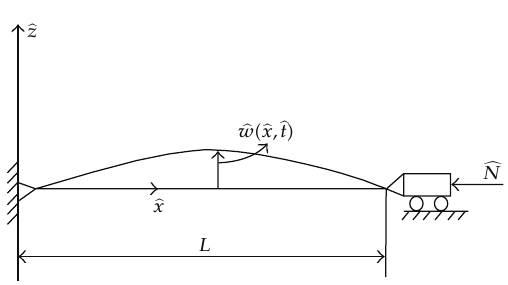
Figure 1: A schematic of a simple ends’